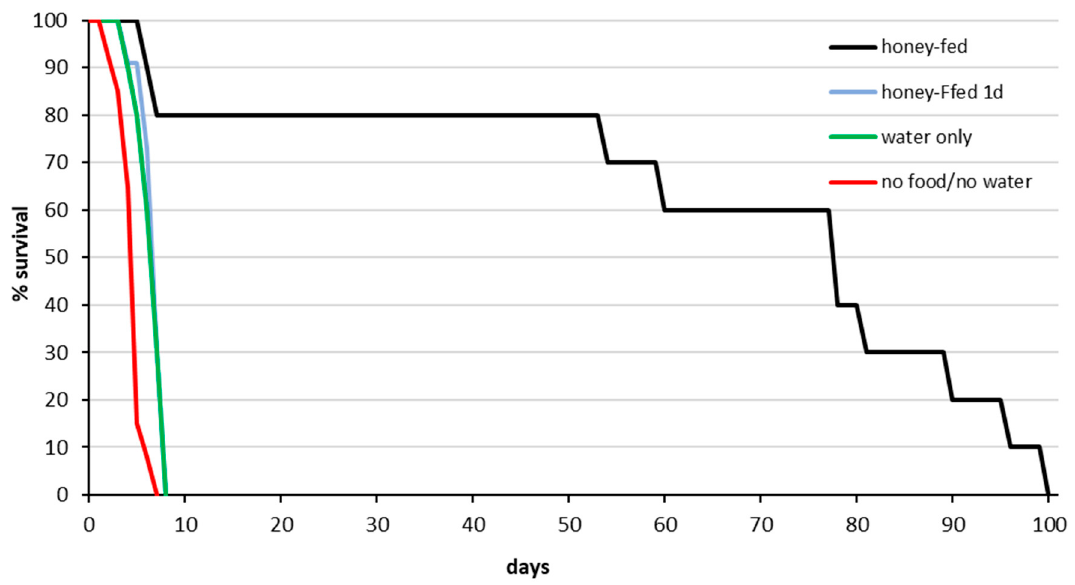
Figure 1. Trissolcus japonicus Beneficial Insects Introduction Research Unit (BIIRU) colony: females adult survival rate at different feeding regimes.